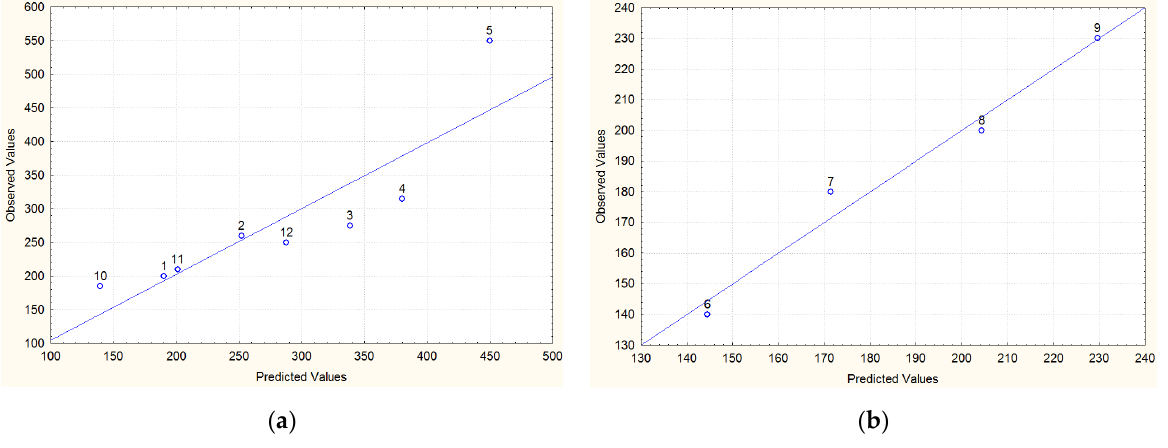
Figure 7. Observed and predicted temperature values ( °C ): ( a ) burnishing w/o lubricant (dry conditions); ( b ) burnishing with lubricant (MQL conditions).